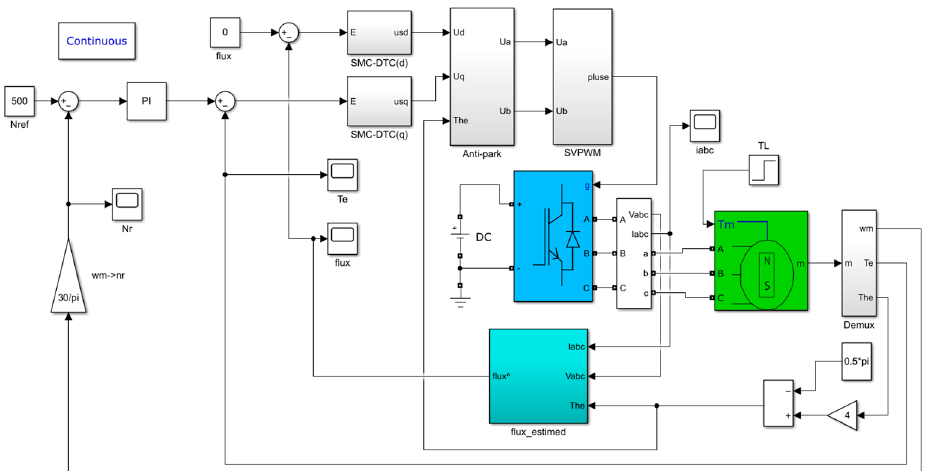
Figure 7. Traditional direct torque control simulation model.